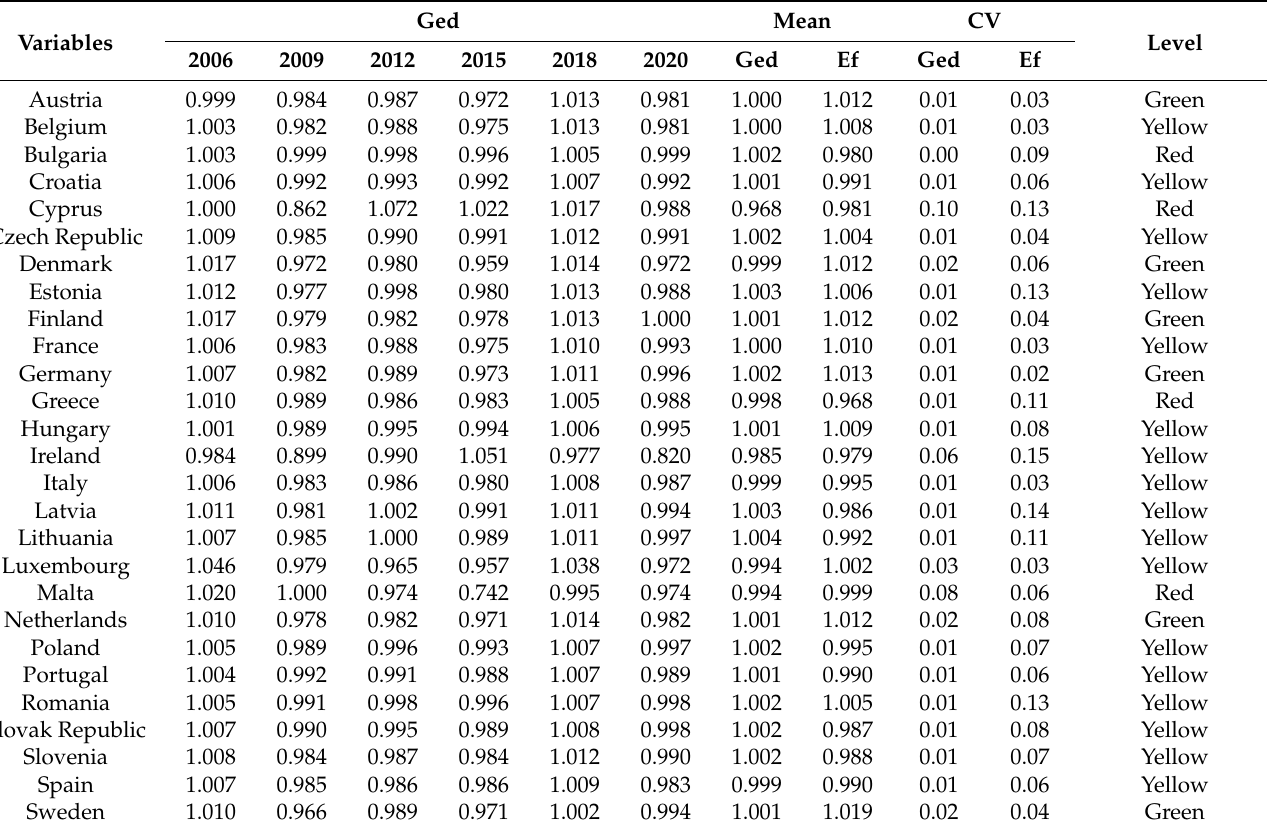
Table 2. The empirical results of Ged and Ef